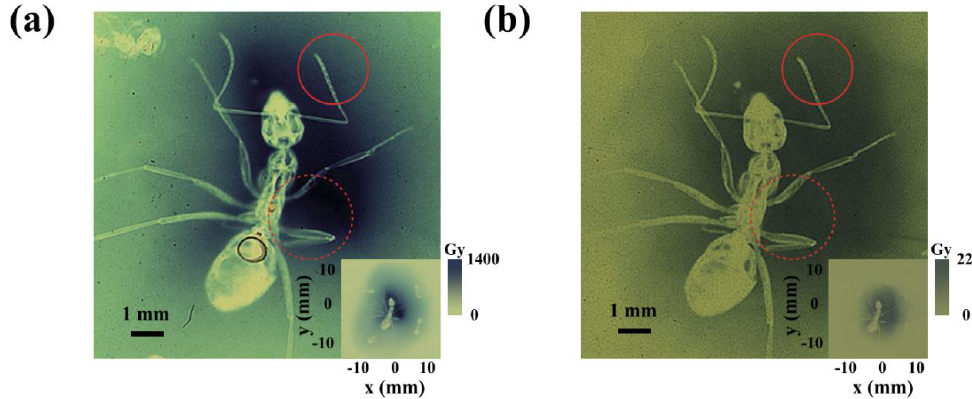
Figure 8. Proton radiography images of an ant on the ( a ) HD-V2 and ( b ) EBT3 RCF. The small images inserted in the lower right corners of ( a , b ) show the complete images of the proton radiography of ants with a proton energy of 2.9 and 5.6 MeV, respectively. The part marked by the solid red line is the antennae, and the part marked by the red dashed line is the tibia.